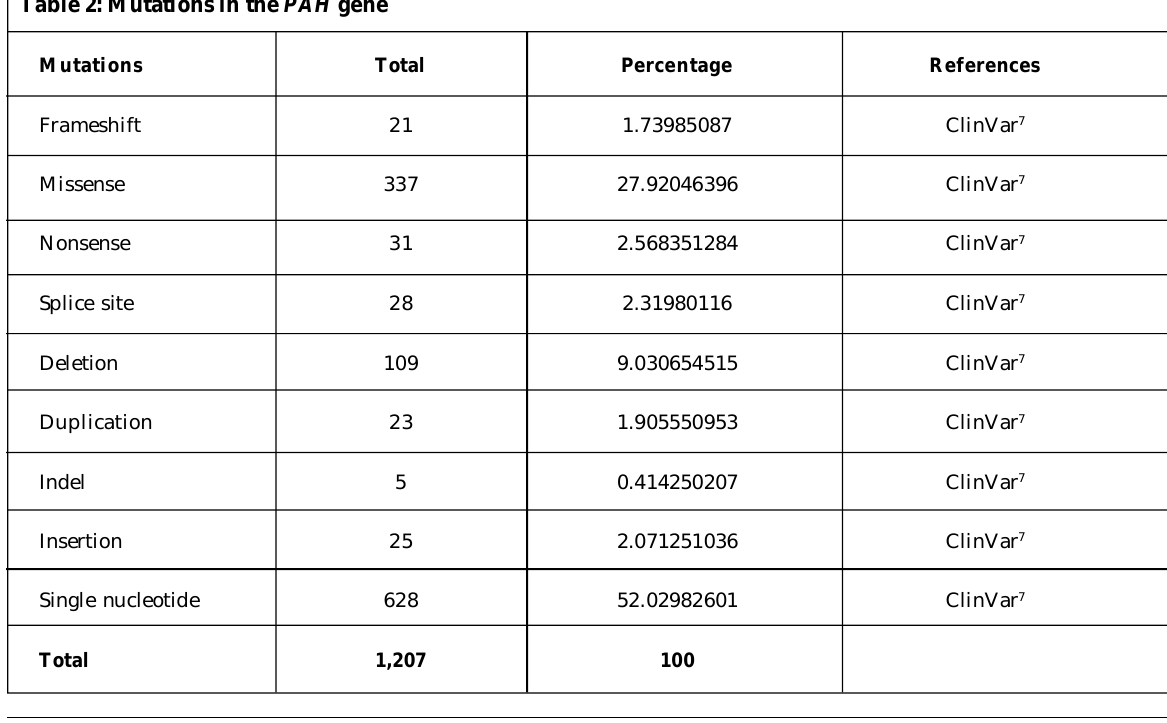
Table 2: Mutations in the PAH gene